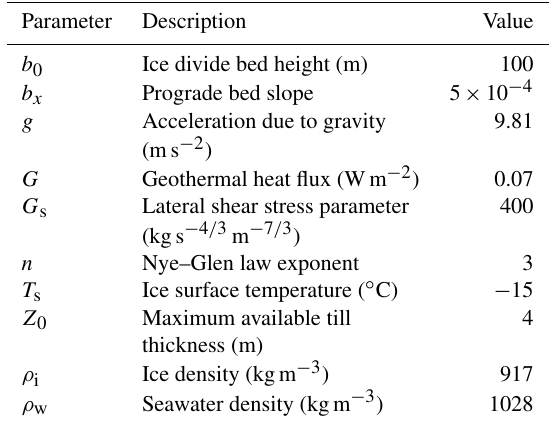
Table 1. Parameters used in this study (unless varied as indicated in Table 2). Other parameters used in the model, but not discussed in the text, are listed in Robel et al.